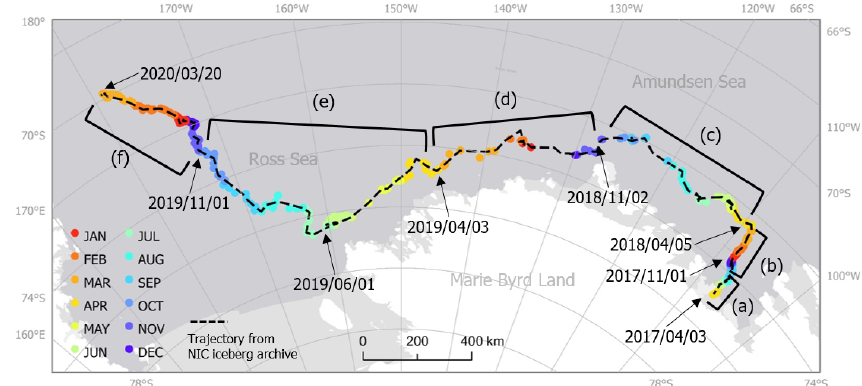
Figure 5. The trajectory of iceberg B43 from our semi-automated algorithm (solid colored circles) and that obtained from the NIC iceberg archive (black dashed line). The circle colors indicate the calendar month. The six square brackets labeled (a) to (f) indicate track segments selected to investigate associations with ice motions and